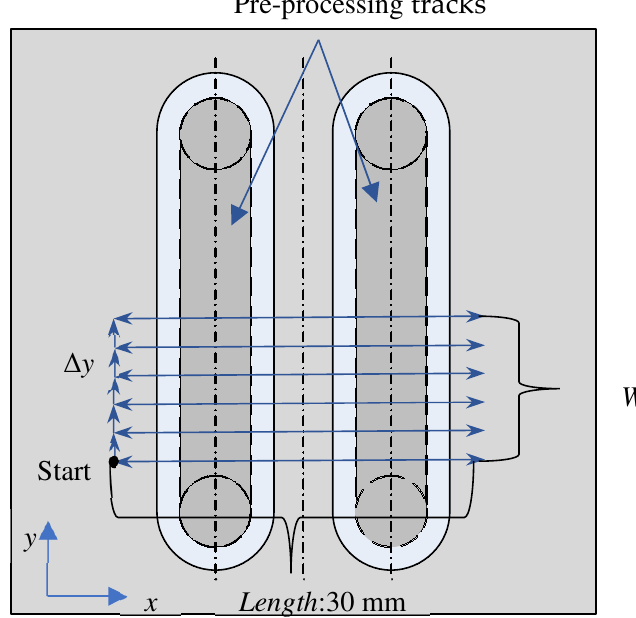
Figure 10. Schematic diagram of processing position.